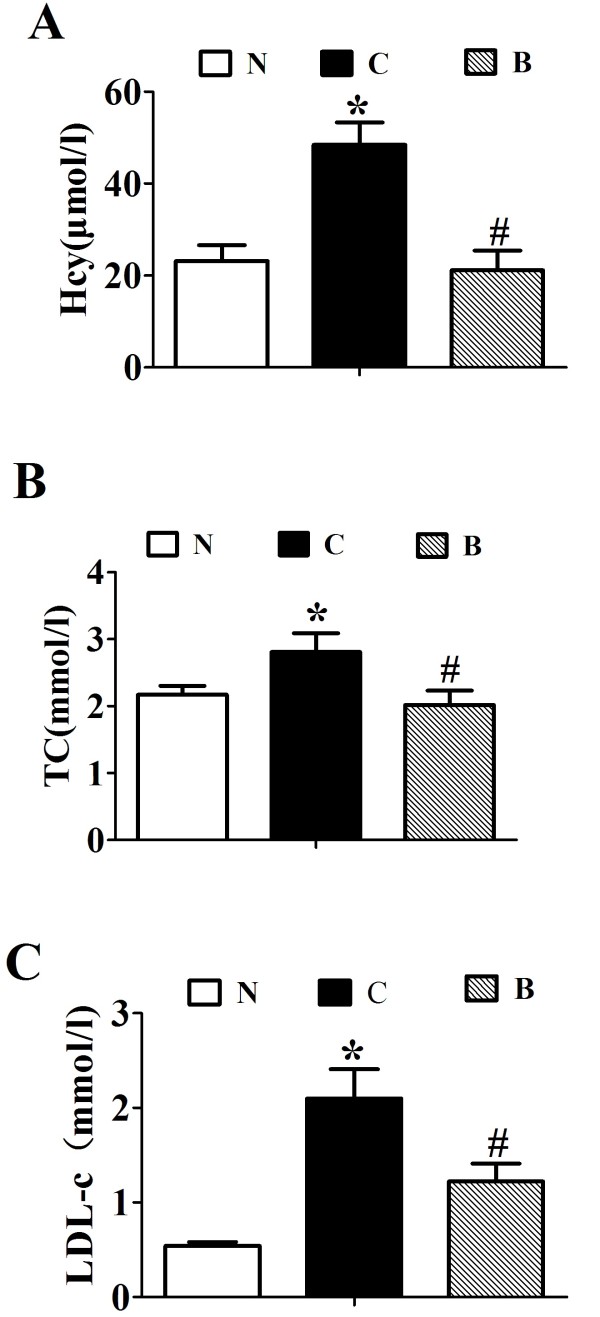
Effects of berberine (BBR) on serum Hcy and lipid profile. Serum Hcy (A), TC (B) and LDL-c (C) are the average of each group (n = 8). N, Normal control; C, vehicle –treated rats fed with HFD; B, rats with berberine treatment (200 mg/kg/d). Values are mean ± SEM. *p < 0.05vs N; #p < 0.05 vs C.